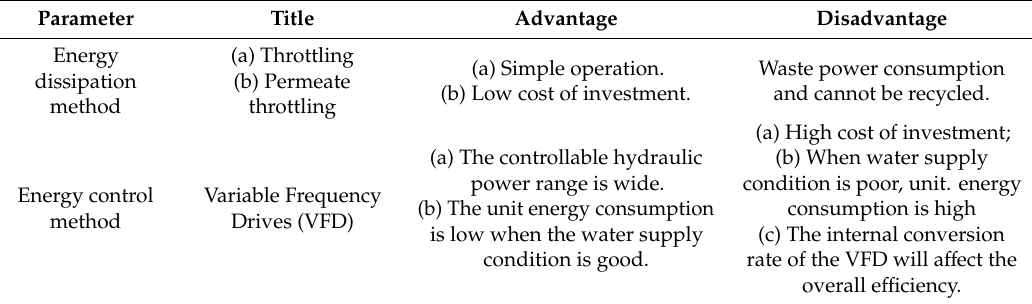
Table 4. Two types of flowrate controlling.